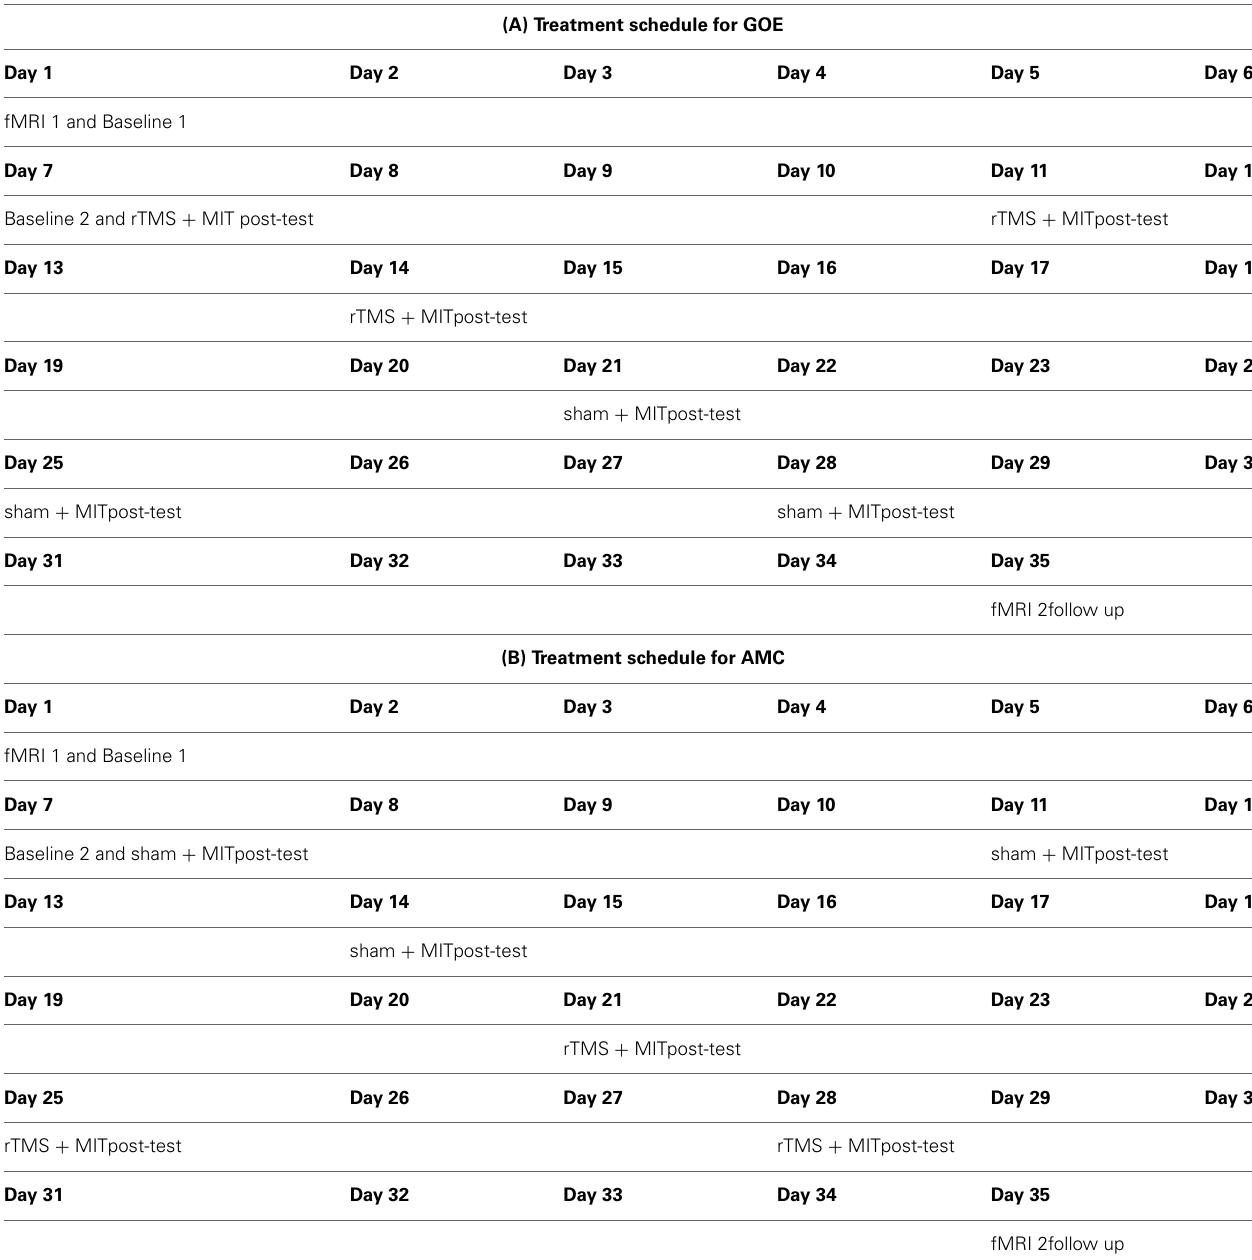
Table 1 | Schedule of treatment for: (A) participant GOE and (B) participant